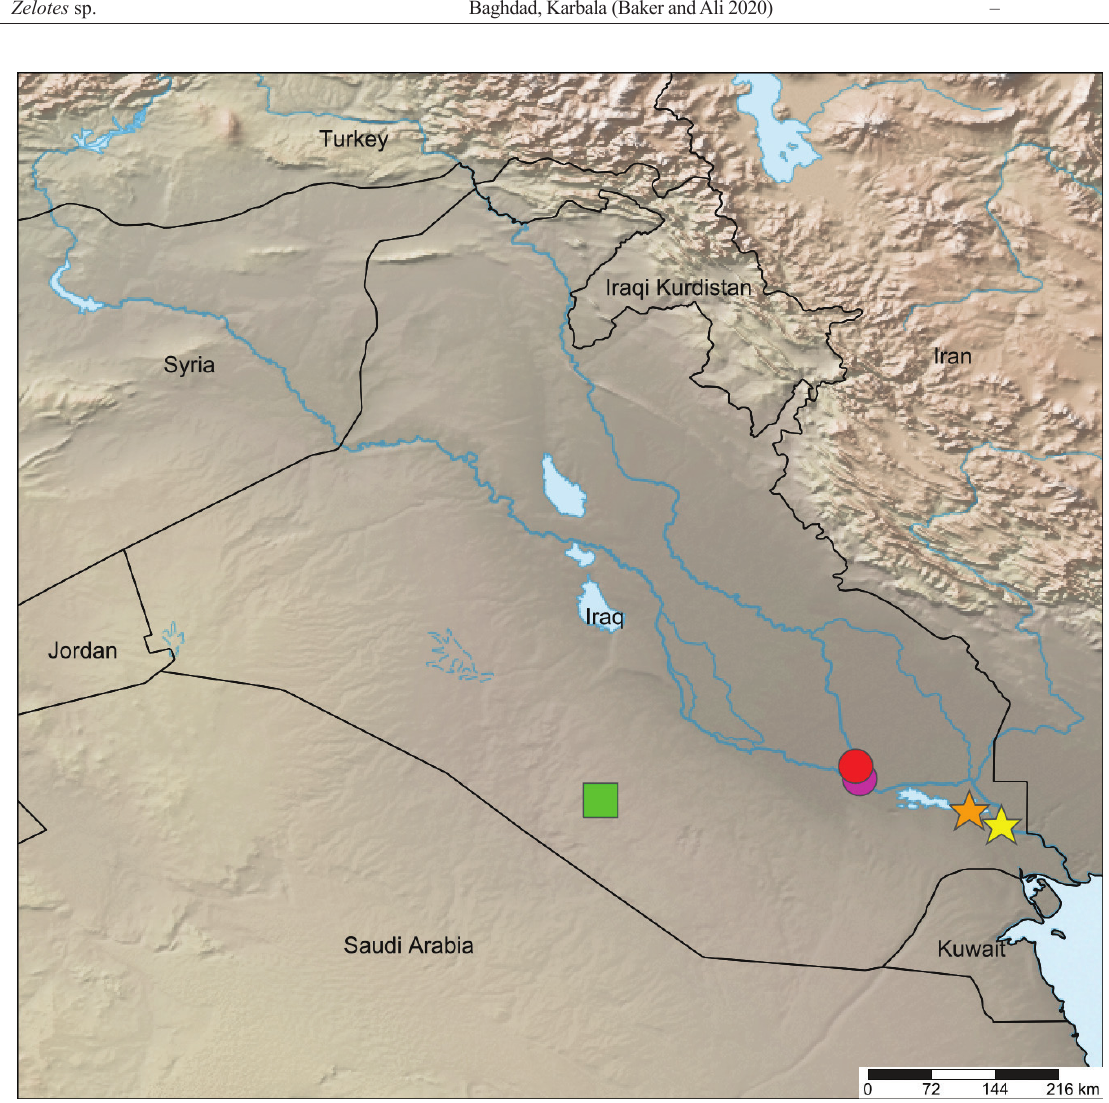
Figure 6. Map of collection localities in Iraq: Basrah, Aboskhair (orange star); Basrah, Qarmat Ali (yellow star); Najaf, Ash Sha- bakah (green square); Thi Qar, Al Azraq (red circle); Thi Qar, Ur (purple